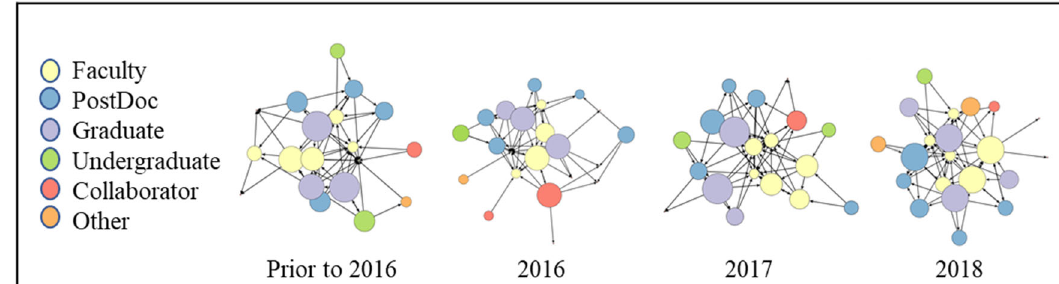
Fig. 6 Mentoring trains future scientists. This diagram was created by using participant answers to the social network question, “ who is your mentor? ” Each circle or node represents a person on the team. The nodes are sized by outdegree to show who reported receiving mentorship. Node size indicates how many mentors an individual reported, and arrows indicate nodes that served as mentors. Colours denote different roles on the